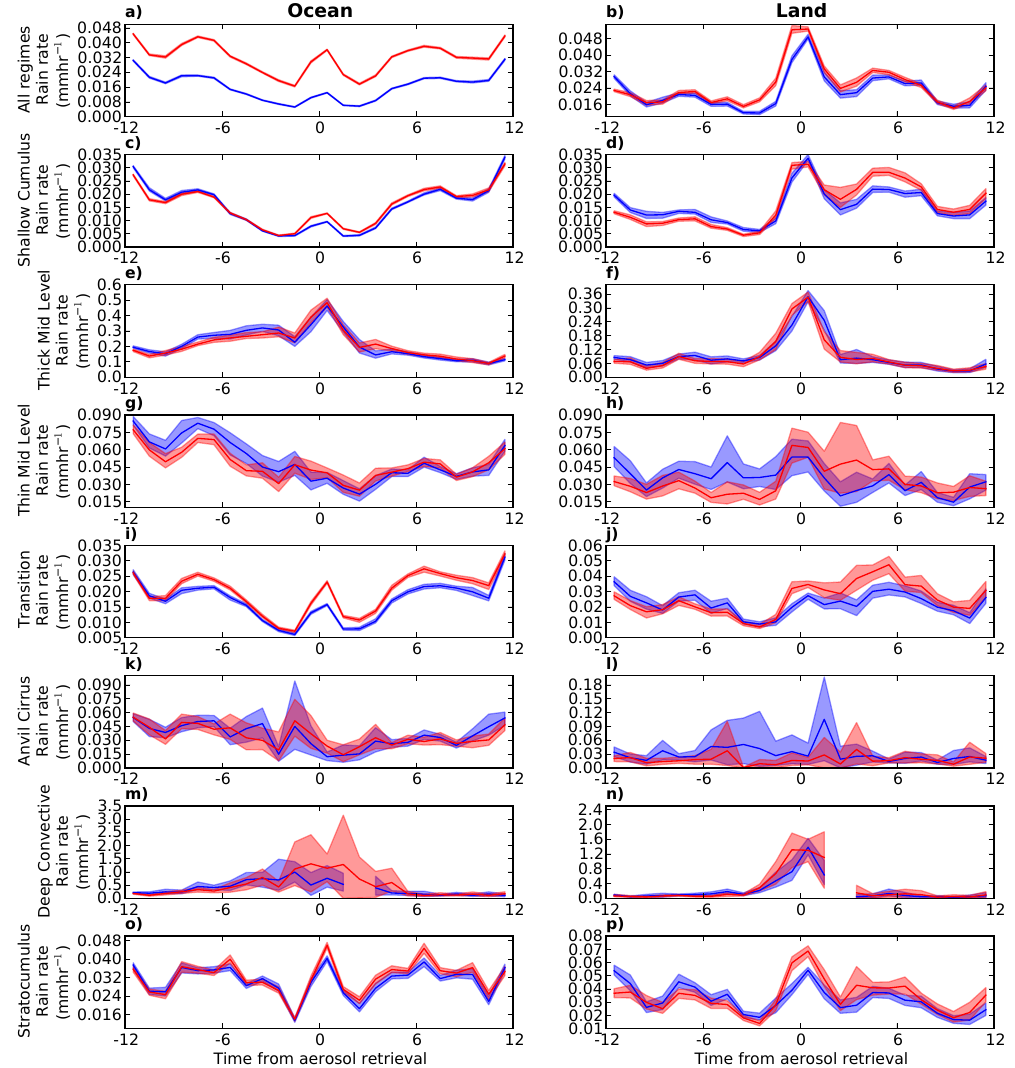
Figure 7. As Fig. 2, but using ISCCP cloud-top temperature (CTT) to remove all clouds with a mean CTT of less then 273K, keeping only liquid-phase clouds. The gaps in the precipitation development of the deep convective regime ( m , n ) indicate a lack of